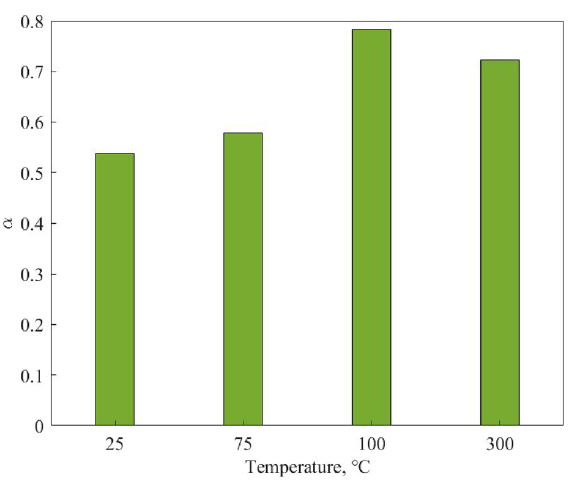
Figure 4. Variation of anisotropic coefficient at elevated temperatures.